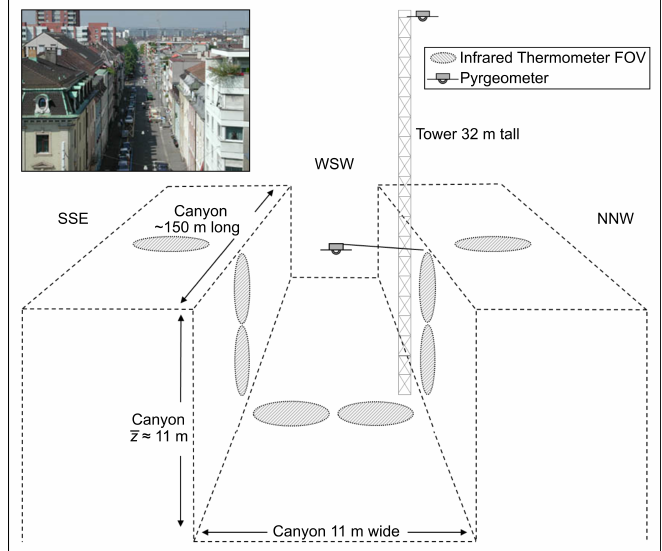
Figure 4. A schematic showing the thermal infrared radiation instrument setup at the Sperrstrasse urban canyon. Pyrgeometer locations and infrared thermometer FOVs for roof, wall, and road facets are indicated. Only instruments relevant to this work are included in the schematic. The canyon photo is taken viewing from the same direction as the